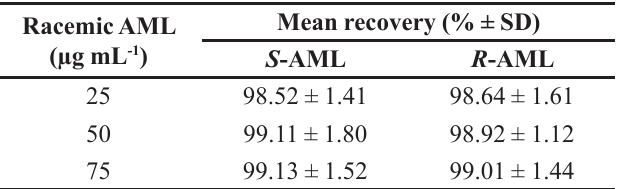
TABLE III - Recovery values obtained from the determination of AML spiked with different levels of standards